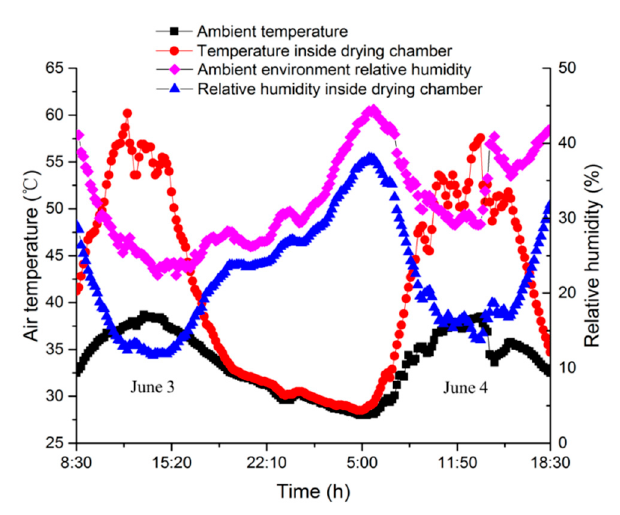
Figure 6. The change of air temperature and relative humidity.